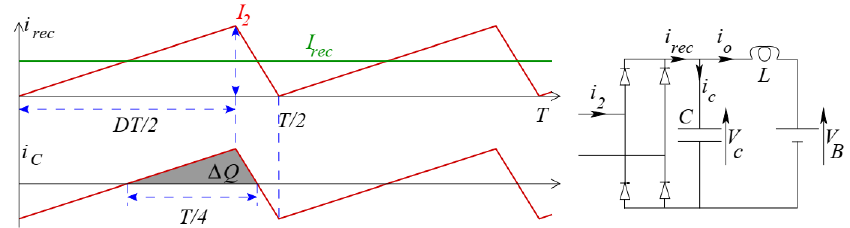
Figure A1. Currents of the rectifier and capacitor filer during the